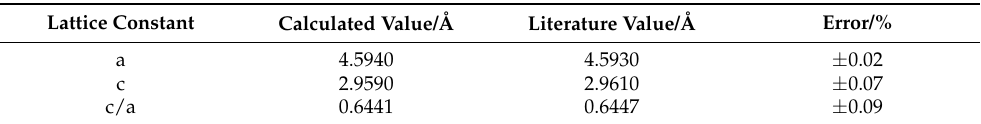
Table 1. Comparison of the lattice constants of rutile TiO 2 between the calculated values and the literature